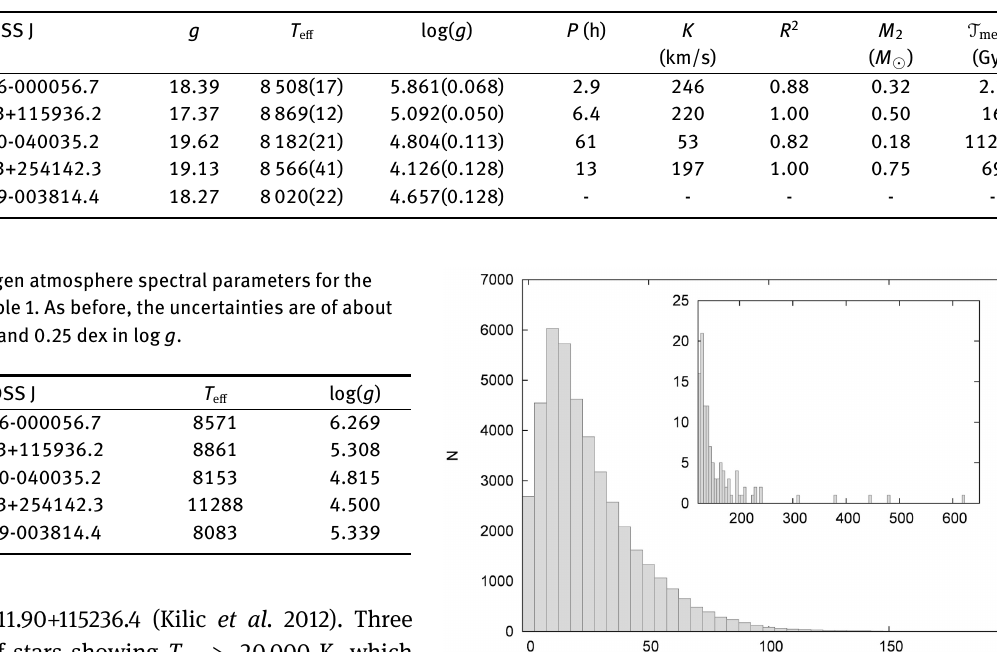
ouslystated,follow-upisdefinitelyneededtostudythena- ture of this object. SDSS J171906.23+254142.3 has five sub- spectra, but less aliasing than SDSS